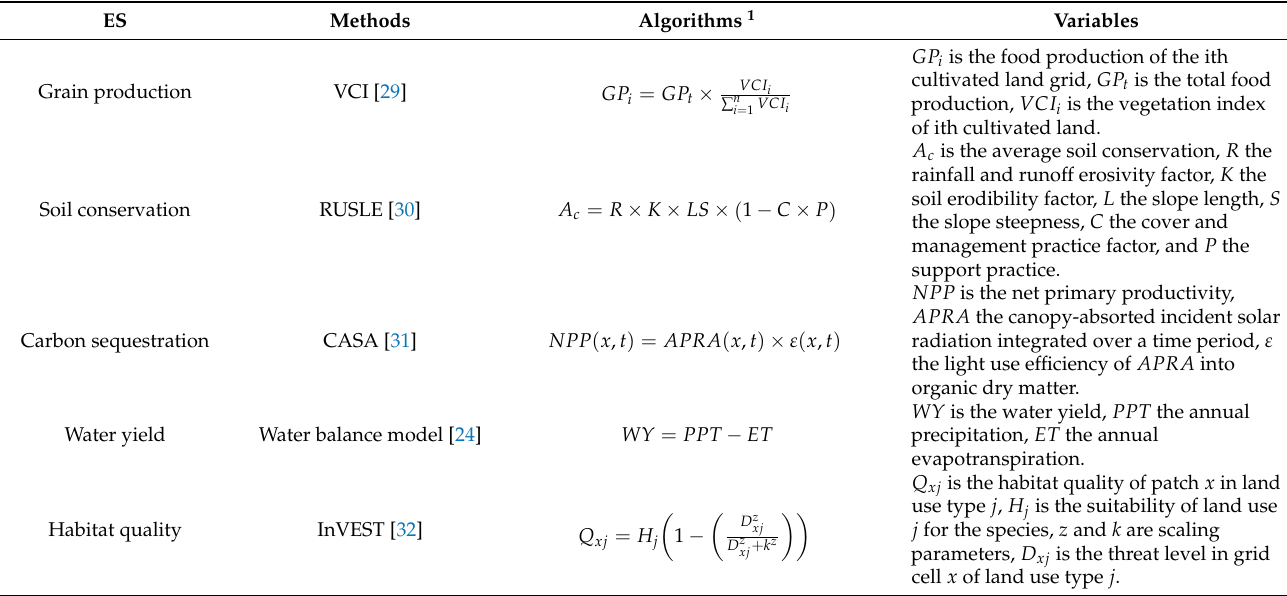
Table 1. Methods for evaluating